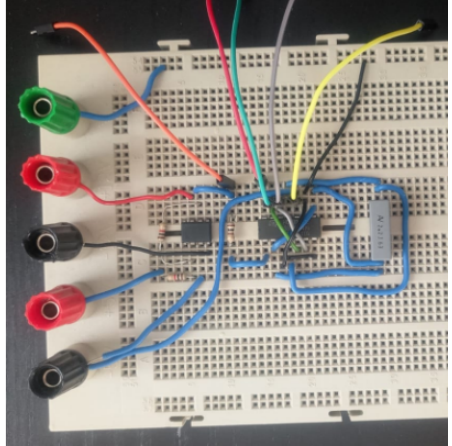
Figure 9. Physical implementation of the circuit on a prototyping board.